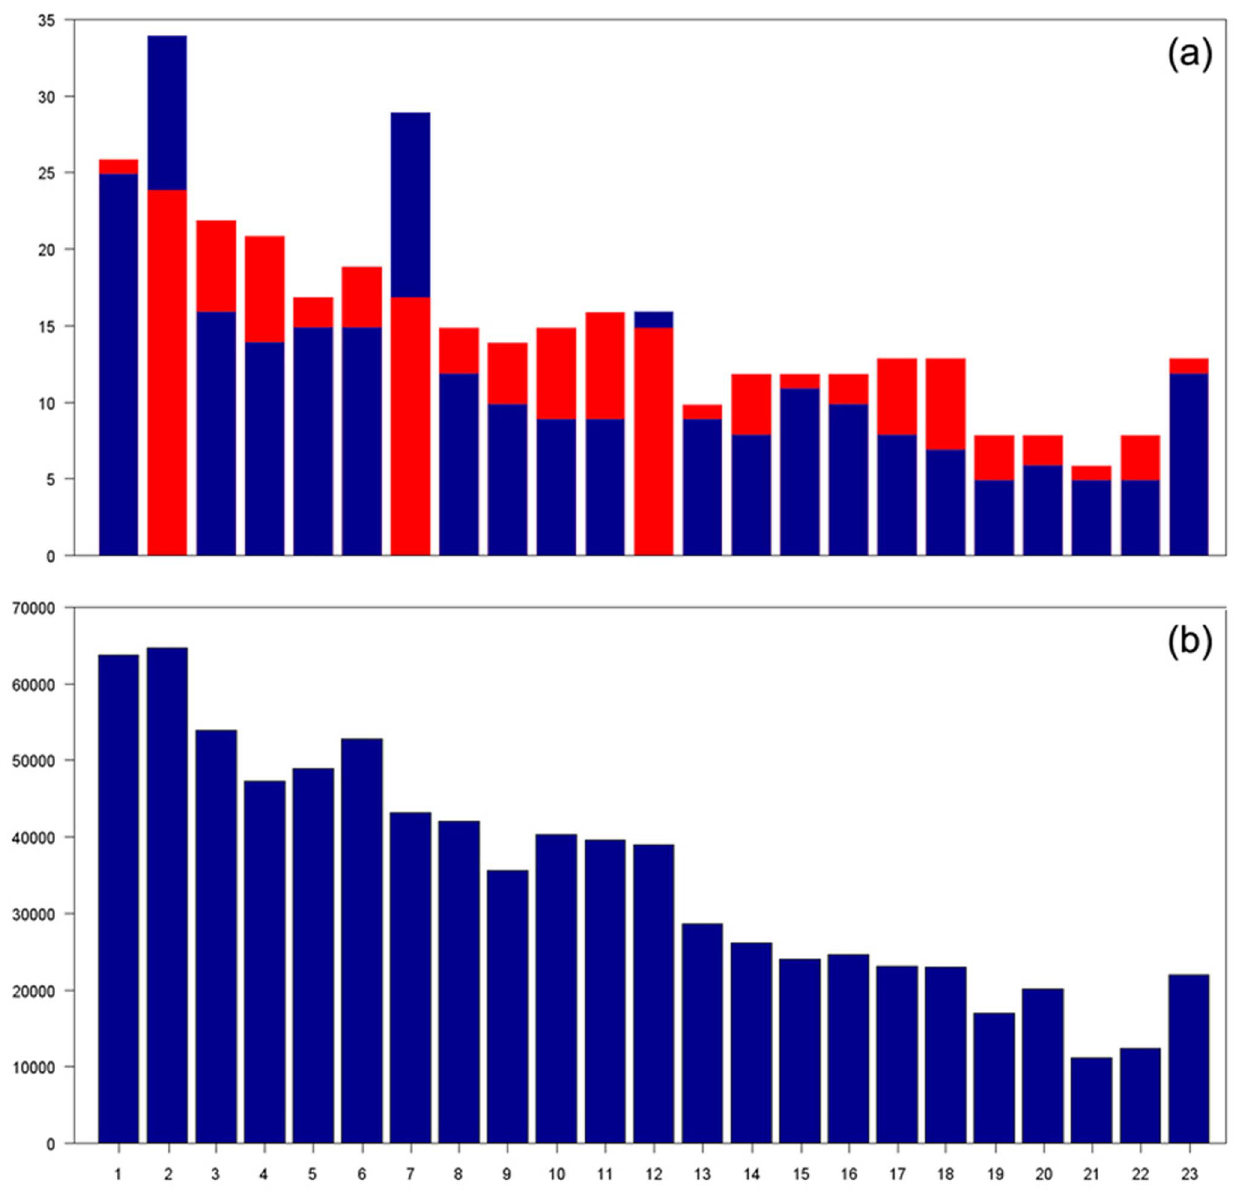
Figure 4. Distribution of cleaned microsatellite and SNP markers on 23 chromosomes in EA families. These markers are used in the combined pedigrees for genotype inference. (a) distribution of microsatellite markers on 23 chromosomes in Map03 (blue) and Marshfield (red) (overlapped); (b) distribution of SNPs on 23 chromosomes in Map03 and Marshfield. Because the difference of SNPs numbers in these two datasets is trivial, we only display the distribution of SNPs in